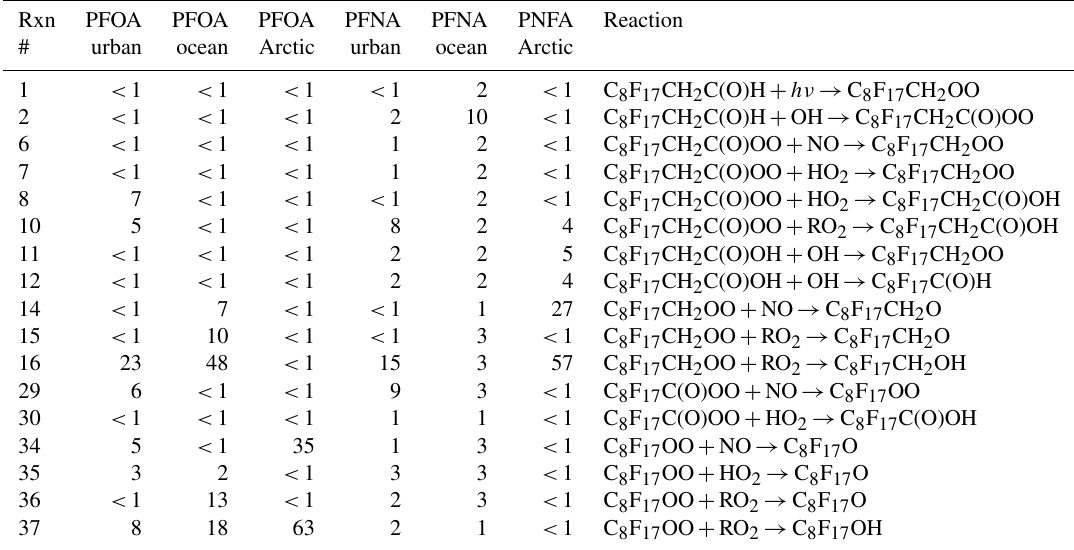
Table 2. Fractional yield uncertainty contributions of rate constants (%).